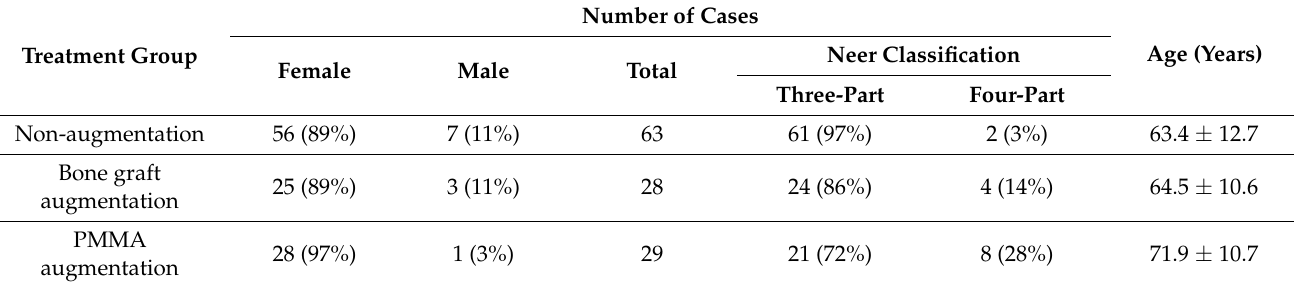
Table 2. Number of cases in the treatment groups according to their characteristics, together with age presented in terms of mean value and standard